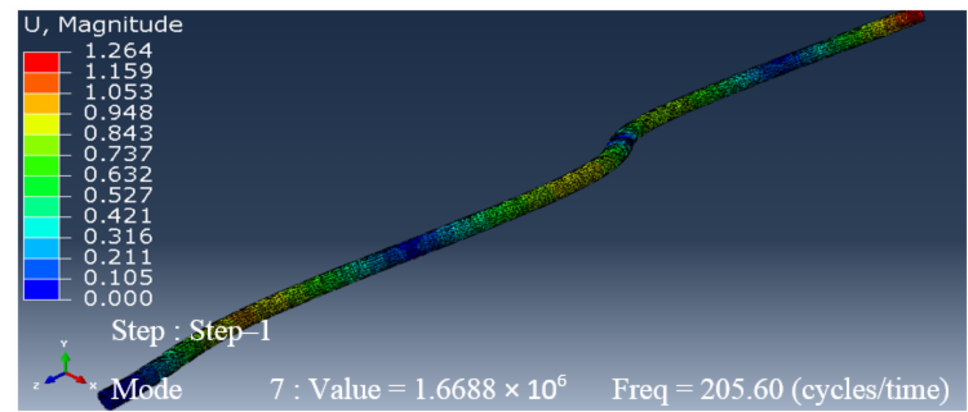
Figure 6. Fourth natural frequency of an undamaged